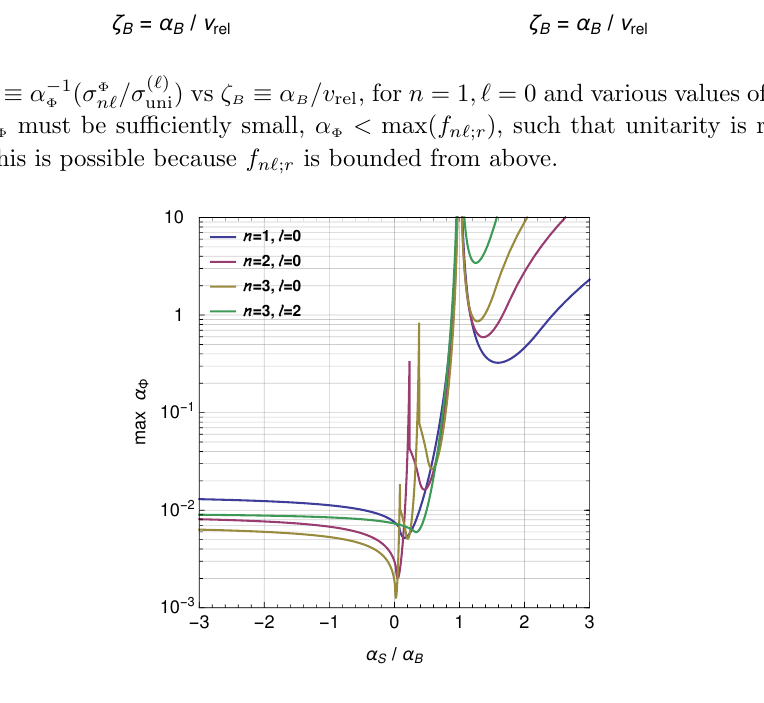
vs. r (cid:17) (cid:11) =(cid:11) , for which the BSF (cid:8) S B